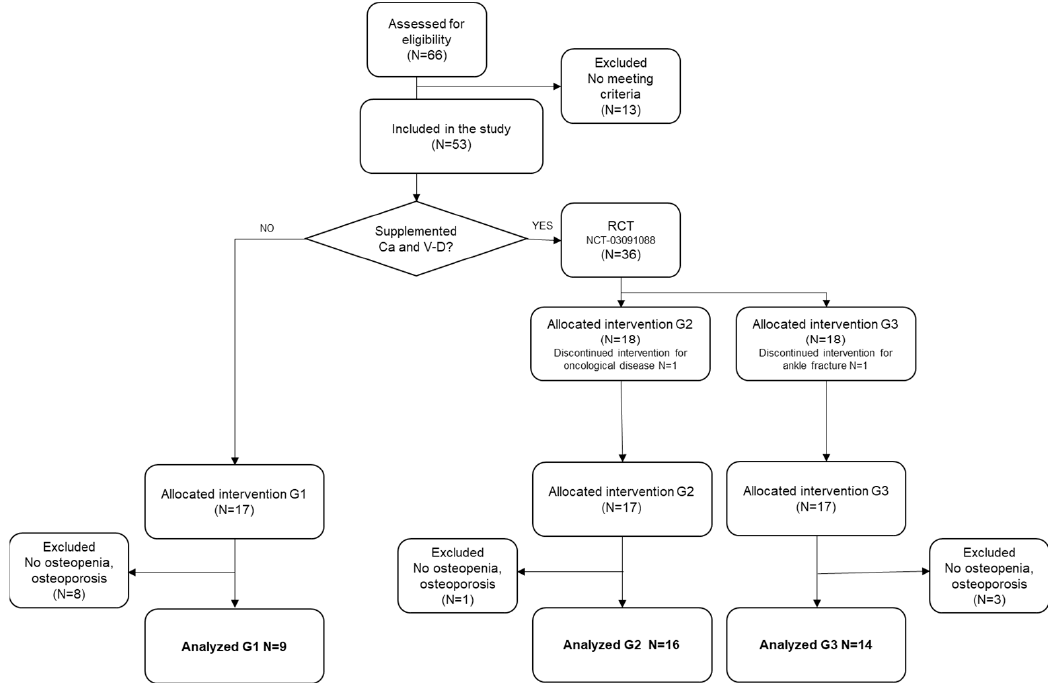
Figure 1. Flow chart of participants. Figure 1.